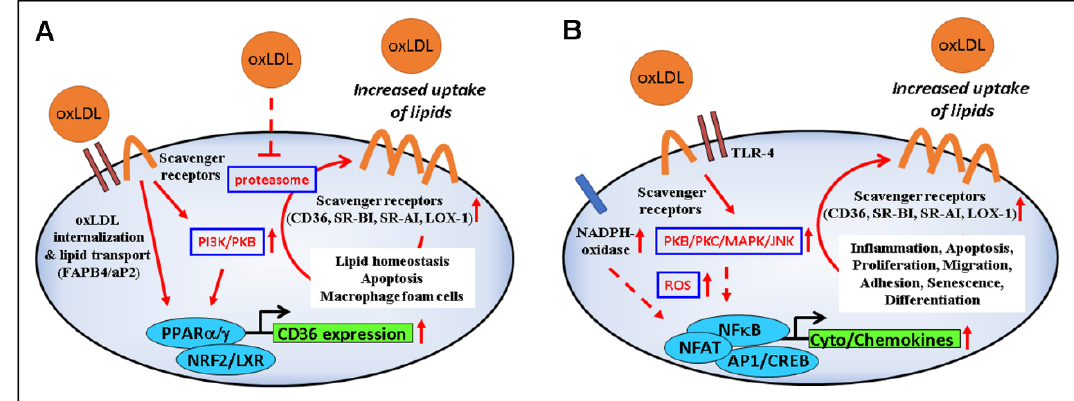
Figure 2. Modulation of signaling and gene expression by oxLDL. ( A ) OxLDL-induced upregulation of scavenger receptors via PI3K/PKB/PPAR γ and proteasome inhibition leads to increased internalization of oxLDLs and their load (lipids, oxidized lipids, and products of lipid peroxidation such as HNE), with consequences on lipid homeostasis, foam cell formation, and cell viability. ( B ) Binding of oxLDLs to scavenger receptors and TLR4 activates the PKB–JNK pathway which, in turn, stimulates NADPH oxidase activity, further supporting ROS production, inflammation, apoptosis, proliferation, migration, cell differentiation, and senescence.